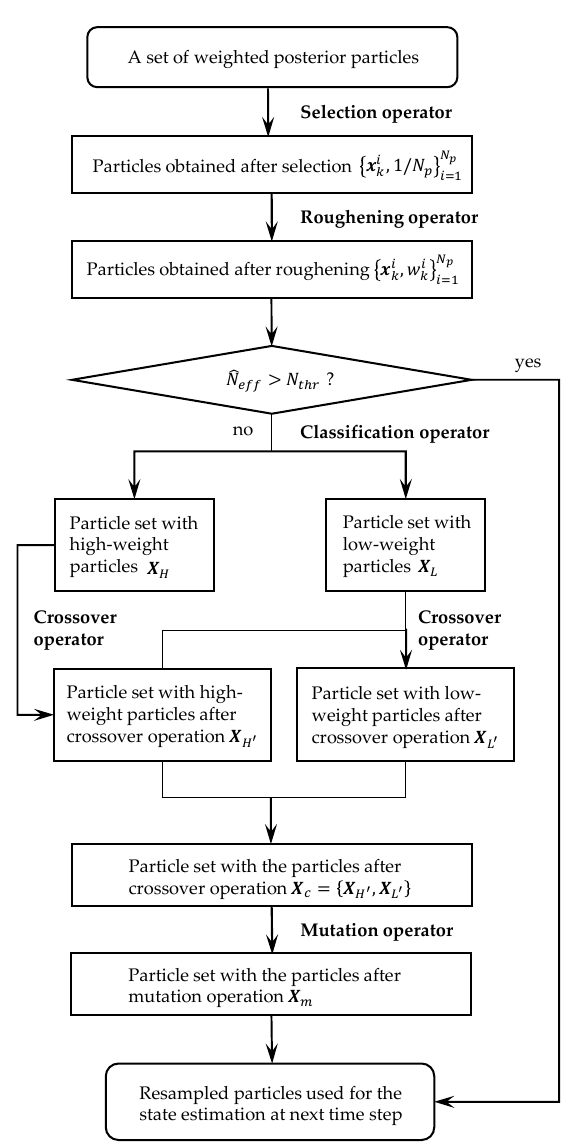
Figure 1. The flowchart of the improved genetic optimization resampling method.